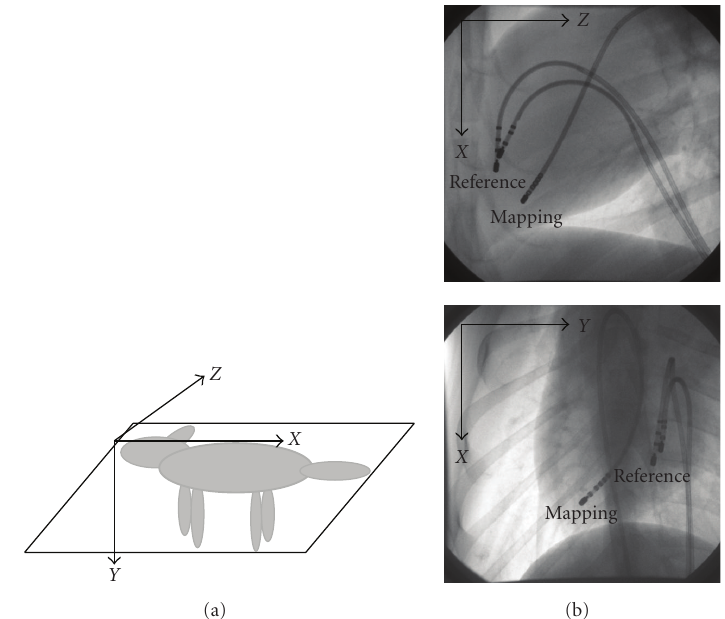
Figure 9: (a) Right-handed coordinate system centered on the tip of the reference catheter. (b) Posterior View: XY plane and Left Lateral View: XZ plane. Images represent diastolic cardiac phase.